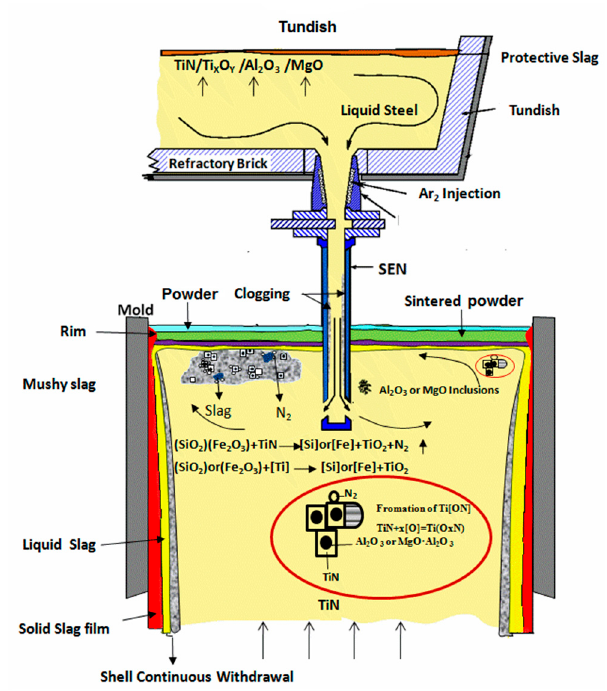
Figure 1. Schematic diagram of steel-slag reaction of Ti-bearing steel in the mold during the continuous casting (CC) process.